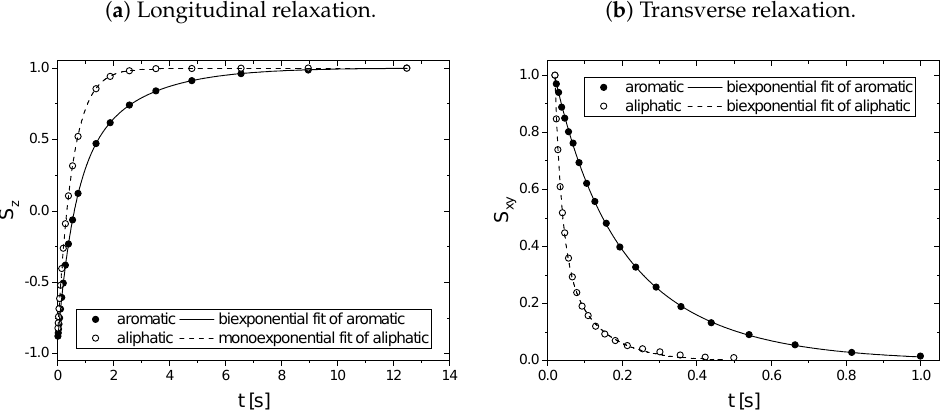
Figure 6. Longitudinal and transverse relaxation curves of the aromatic and aliphatic protons in a solution consisting of 150 g/L asphaltene in benzene-d 6